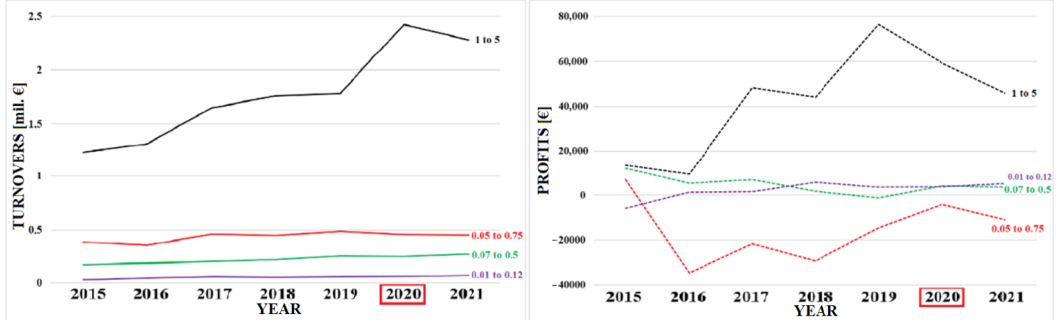
Figure 8. Development of the average turnovers and profits of selected wine companies [56].